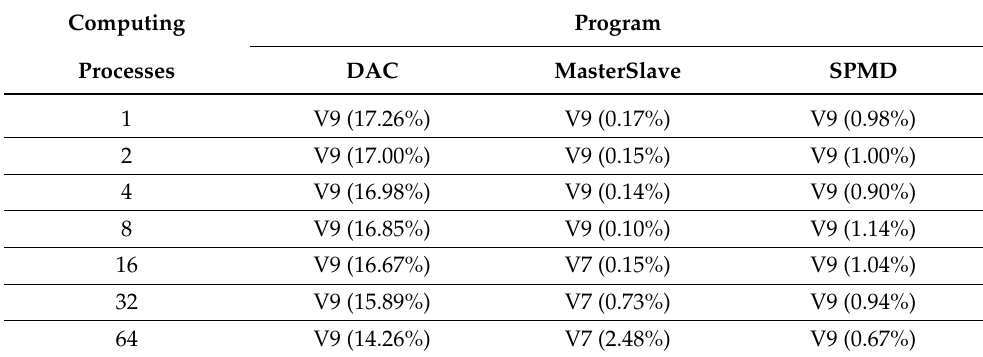
Table 9. Better compiler version using